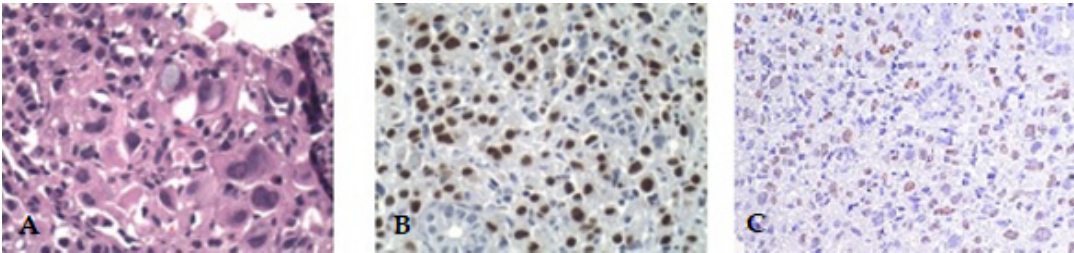
Figure 3. Immunohistochemistry of the colon biopsy showing a result compatible with breast cancer infiltration. ( A ): Hematoxylin ‐ eosin staining, ( B ): GATA3 expression (L50–823 clone), ( C ): Estrogen receptor expression (EP1 clone).